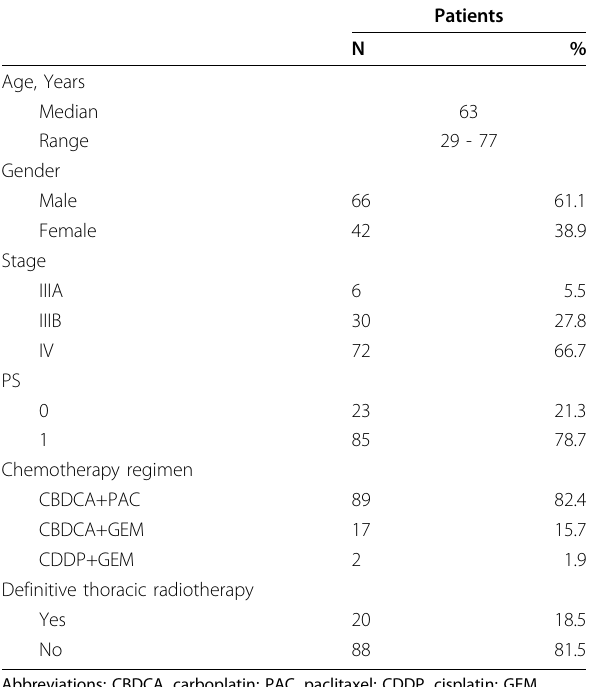
Table 1 Characteristics of the 108 patients with non- small-cell lung cancer enrolled in the study